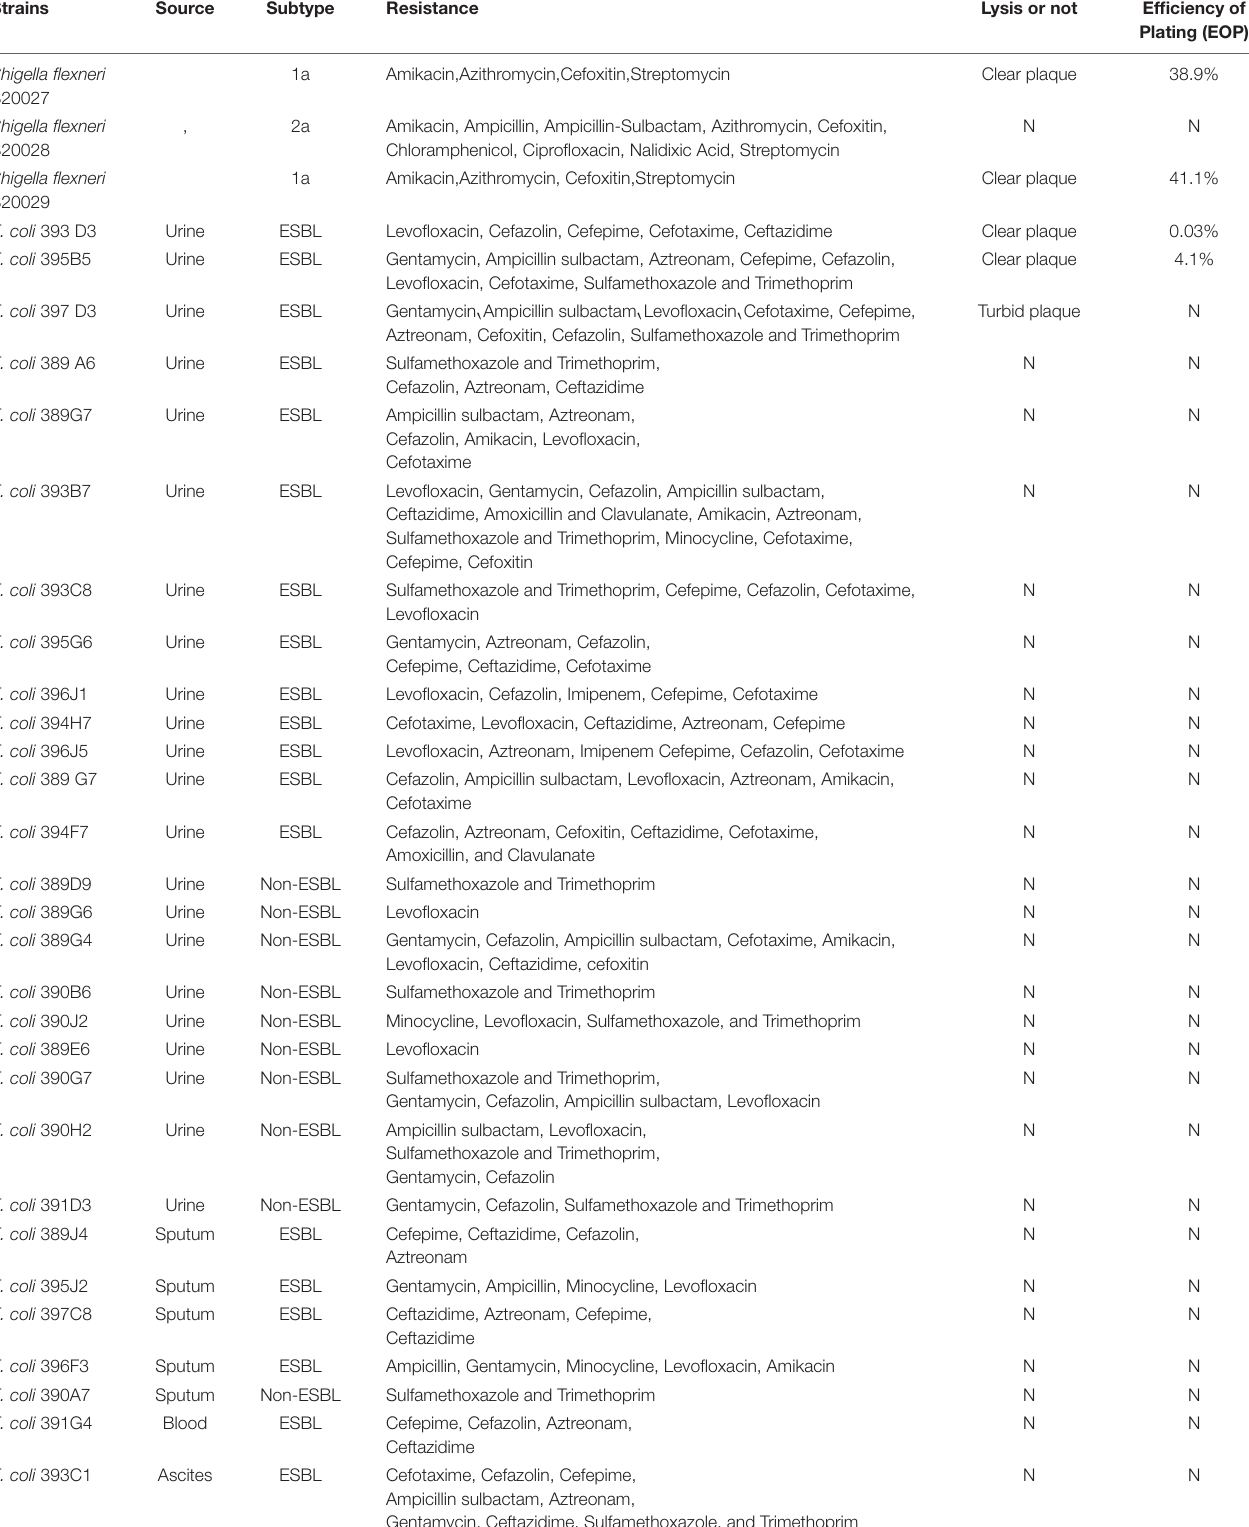
ESBL Cefotaxime, Cefazolin, Cefepime, Ampicillin sulbactam, Aztreonam, Gentamycin, Ceftazidime, Sulfamethoxazole, and Trimethoprim Negative results are indicated by